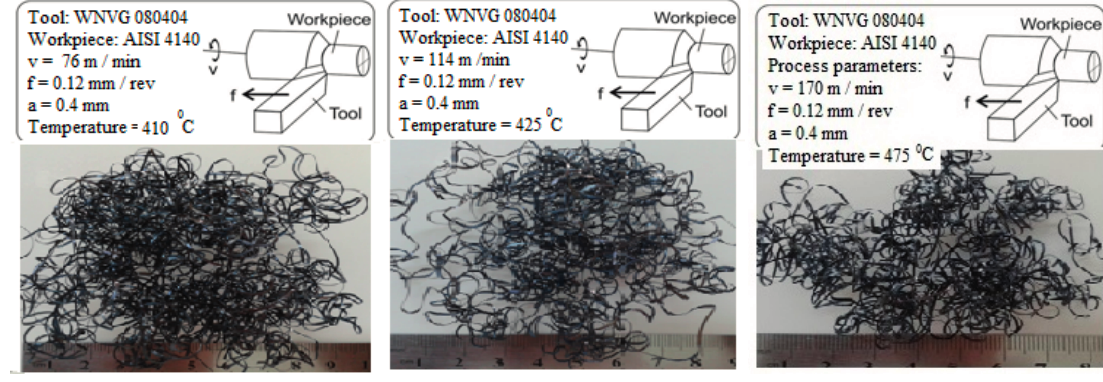
Figure 13. Chips form at different tool-chip interface temperatures and cutting